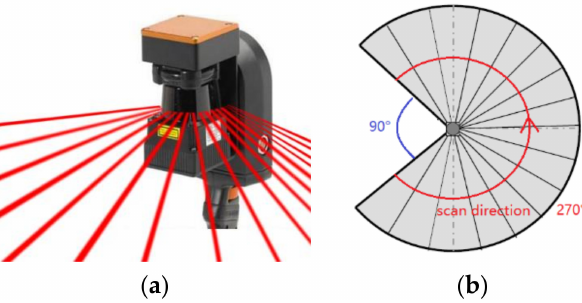
Figure 3. Example of scanning angle in 3D ( a ) and 2D ( b